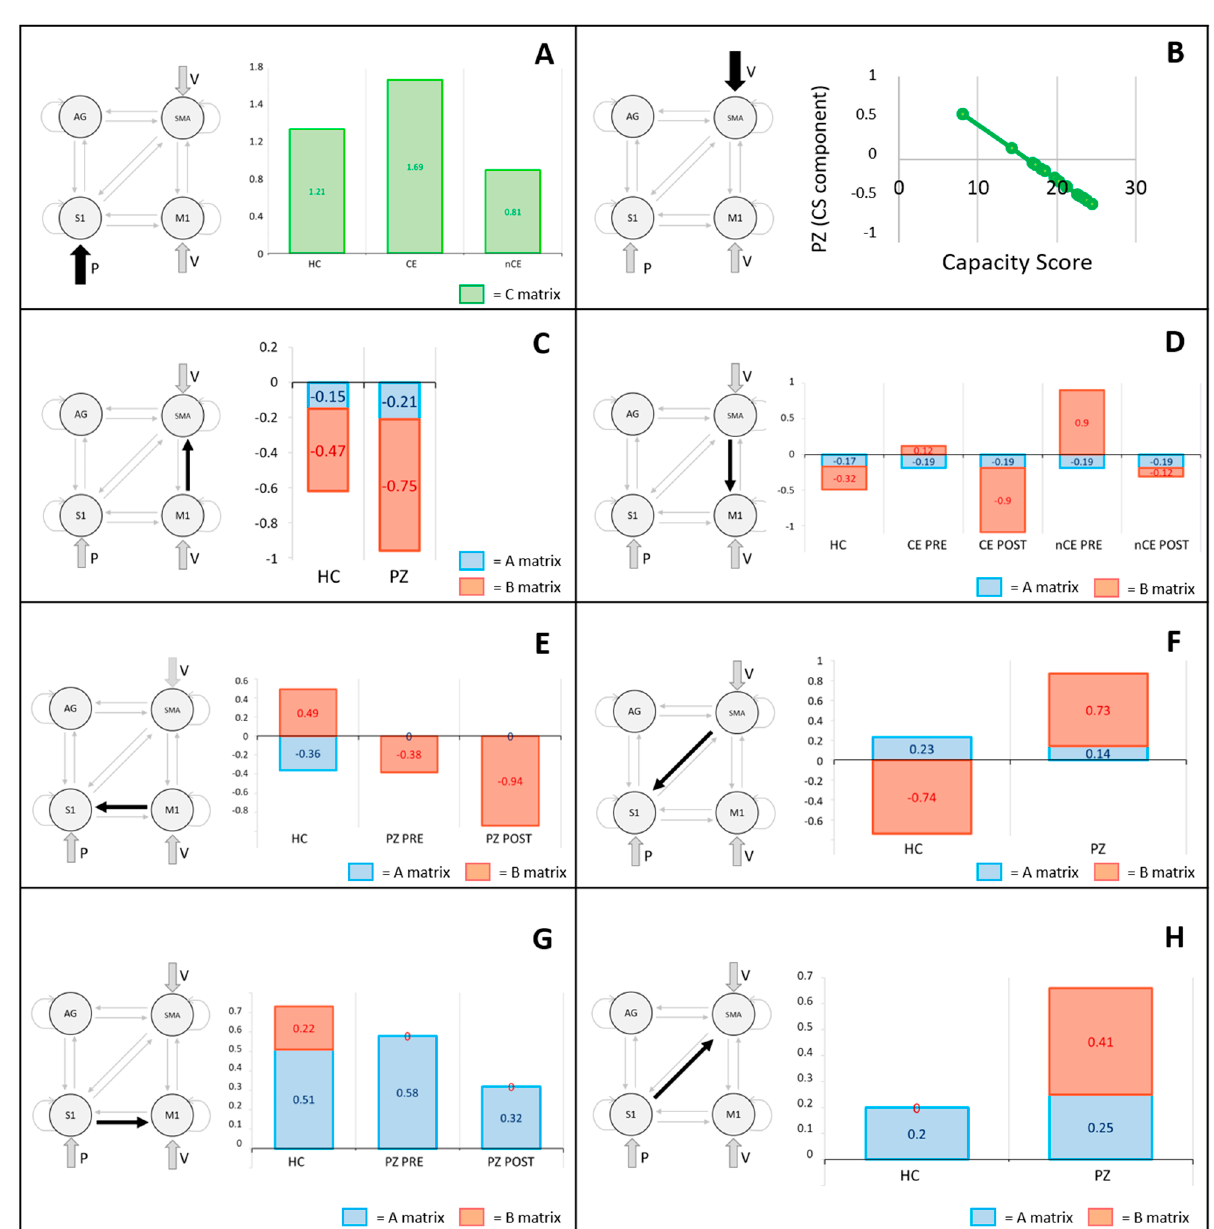
Figure 4. Graphical representation of estimated values for patients and healthy controls. ( A ) input matrix (i.e., C matrix) on S1 area. ( B ) Dependence of the influence of V factor (i.e., C matrix) over SMA area on the capacity score value. Intrinsic and extrinsic estimated parameters (i.e., A matrix – blue bars, B matrix – red bars) for ( C ) M1 to SMA connection; ( D ) SMA to M1 connection; ( E ) M1 to S1 connection; ( F ) SMA to S1 connection; ( G ) S1 to M1 connection; ( H ) S1 to SMA connection. V: voluntary input; P: proprioceptive input; M1: primary motor cortex; S1: primary sensorimotor cortex; SMA: supplementary motor area; AG: angular gyrus; CE: carryover effect responders; nCE: carryover effect non-responders; HC: healthy controls; PZ: patients; “pre” represent to code for pre-training (or baseline) acquired images; “post” represents the code for post-training acquired images.